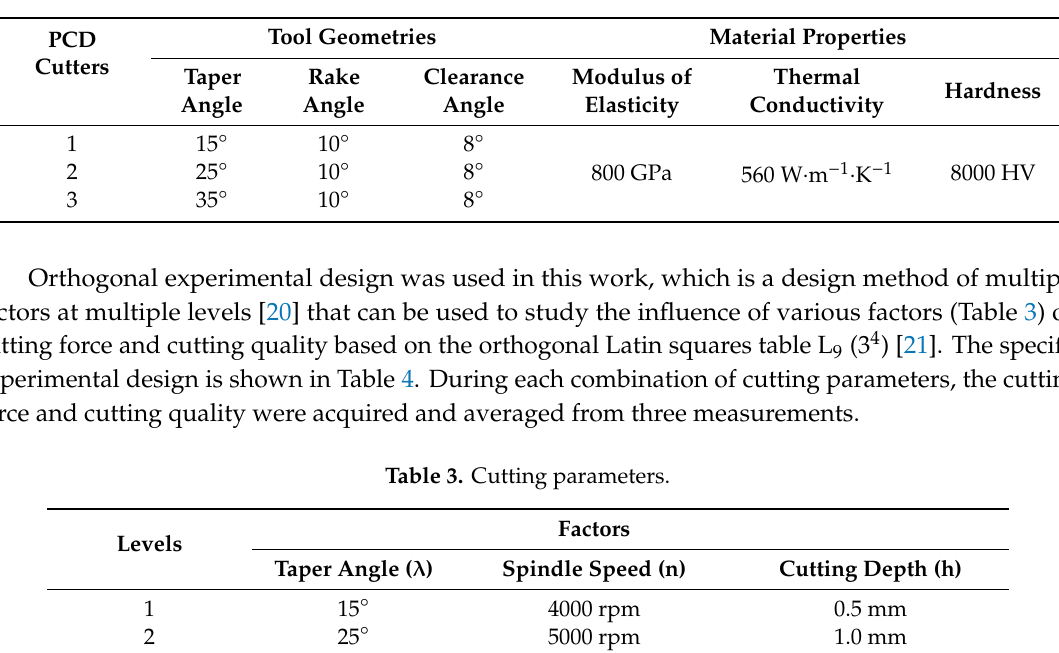
Table 2. Tool angle and properties of polycrystalline cemented diamond (PCD) cutters.